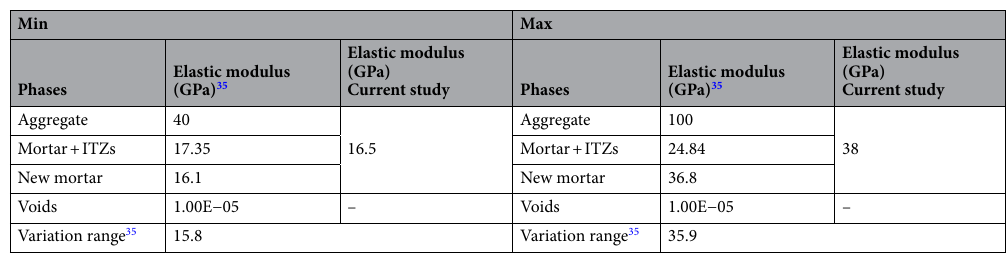
Table 12. Elastic properties of RAC phases along with variation interval for the elastic modulus.